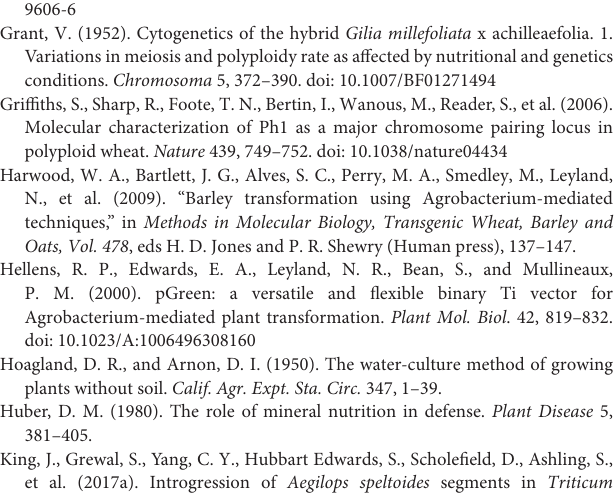
according to Dunn’s test. Different letters indicate significant differences between